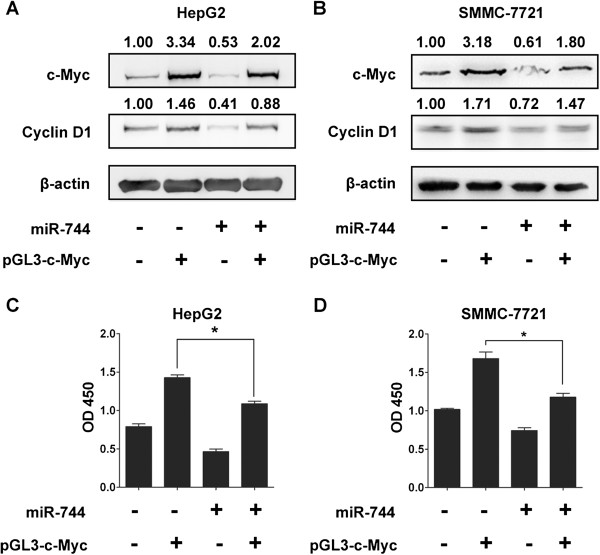
miR-744 inhibits c-Myc-dependent activity and cell proliferation in HCC cells. (A, B) miR-744 inhibits c-Myc-dependent transcription of the c-Myc target gene Cyclin D1. HepG2 and SMMC-7721 cells were transfected with miR-744 and/or pGL3-c-Myc, and the expression of c-Myc and Cyclin D1 were analyzed by Western blotting. The value up each lane indicates the protein expression with β-actin as an internal control. (C, D) miR-744 inhibits c-Myc-dependent cell proliferation. HepG2 and SMMC-7721 cells were transfected with miR-744 and/or pGL3-c-Myc, and cells proliferation was measured by CCK-8 analysis. The data were subjected to Student's t-test. *p < 0.05.